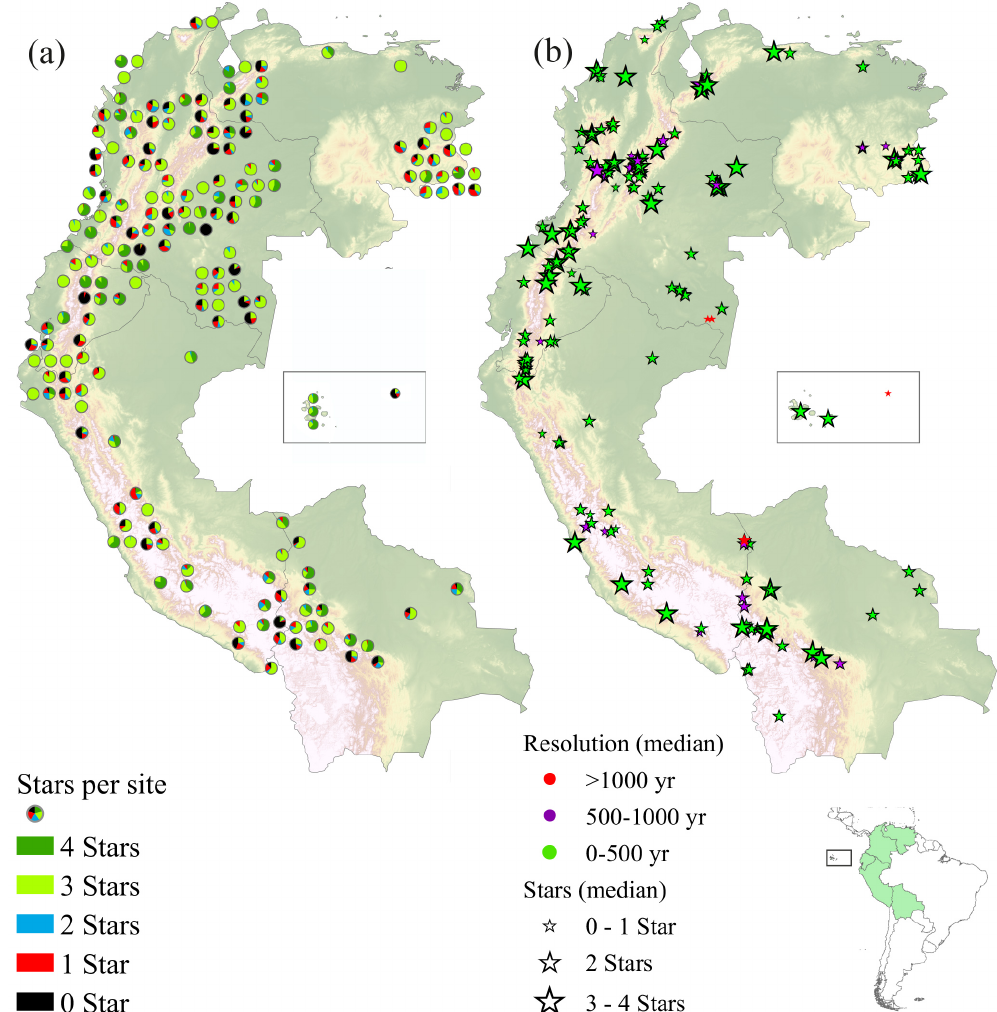
Figure 3. Temporal uncertainty assessment on recalibrated control points and age models in northwest South America. (a) Number of stars assigned to samples of recalibrated chronologies (normalized to 100%). (b) Median value of stars and resolution of the recalibrated chronologies. The small window displays the region of the Galapagos Islands and the marine core